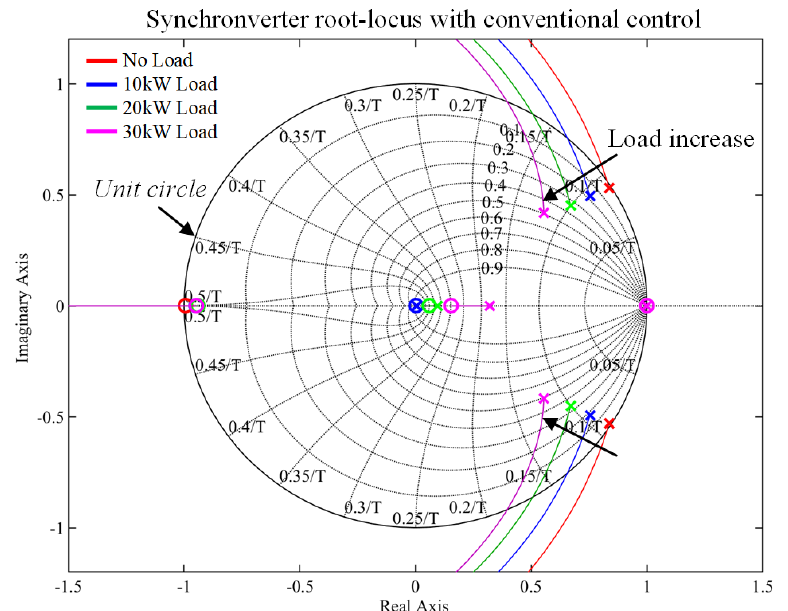
Figure 3. Root − locus of conventional synchronverter control method in islanded power